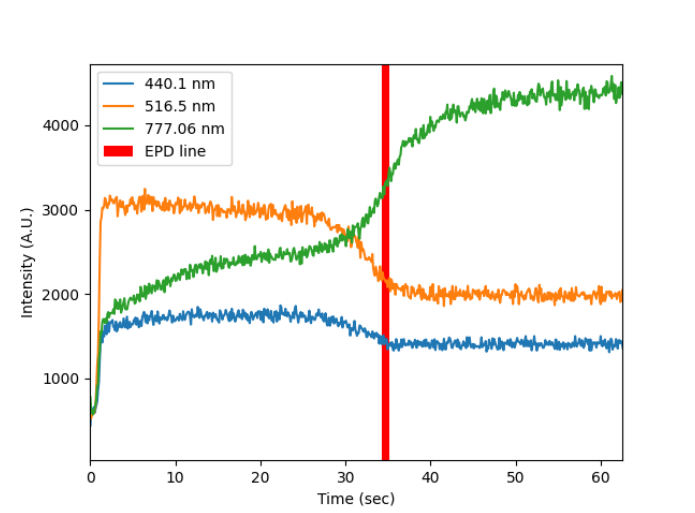
Figure 5. Intensity fluctuations of the wavelengths of 440.1 nm, 516.5 nm, 777.06 nm, which are related to C 2 and SiF with respect to time. The red line denotes the ground truth EPD time.